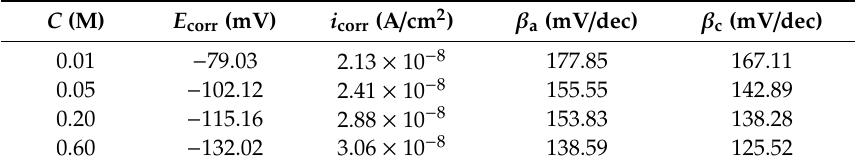
Figure 3. The potentiodynamic polarization (PDP) curves of galena in di ff erent concentrations of NaCl solutions at pH 6.7. Table 1. The corrosion parameters obtained from the PDP measurements for the galena electrode in NaCl solutions of di ff erent